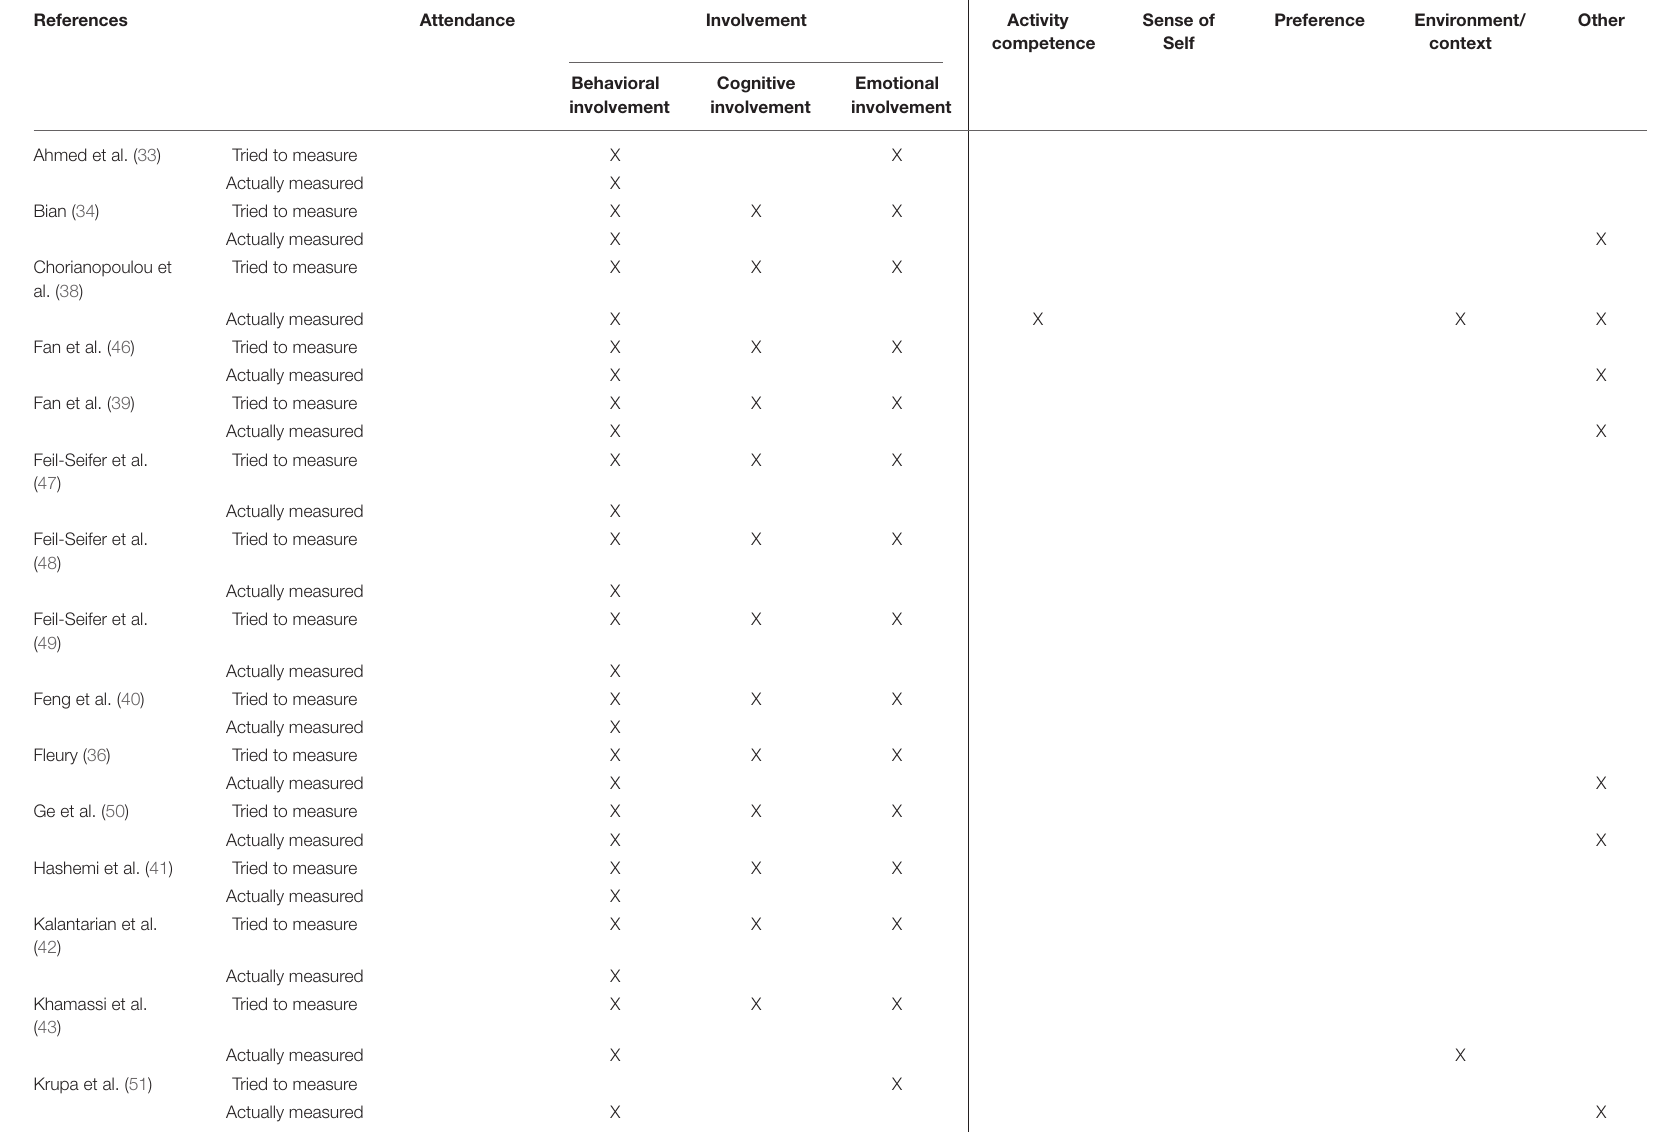
TABLE 3 | Operationalization of